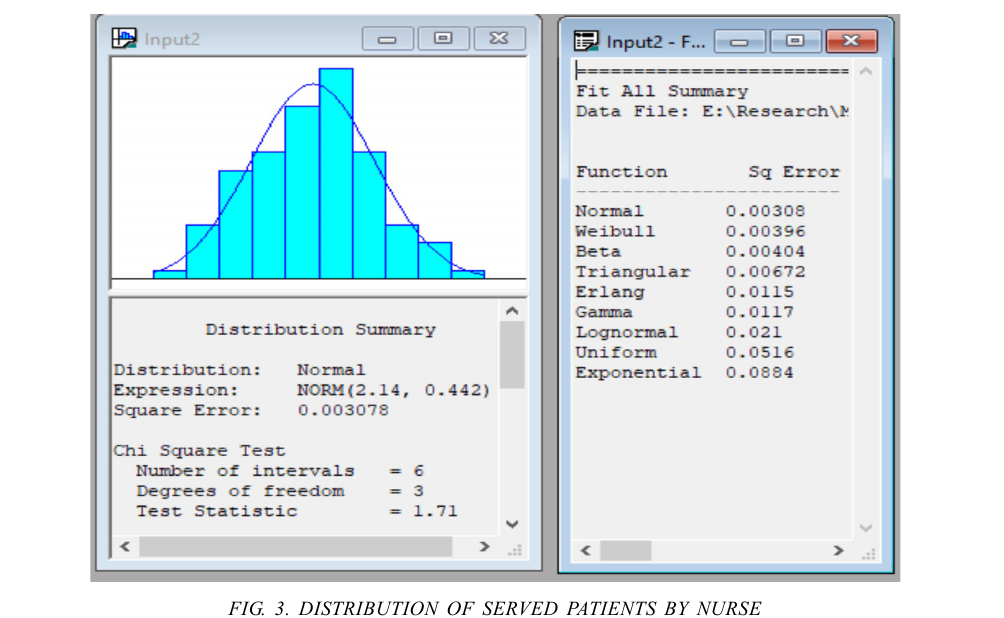
FIG. 3. DISTRIBUTION OF SERVED PATIENTS BY